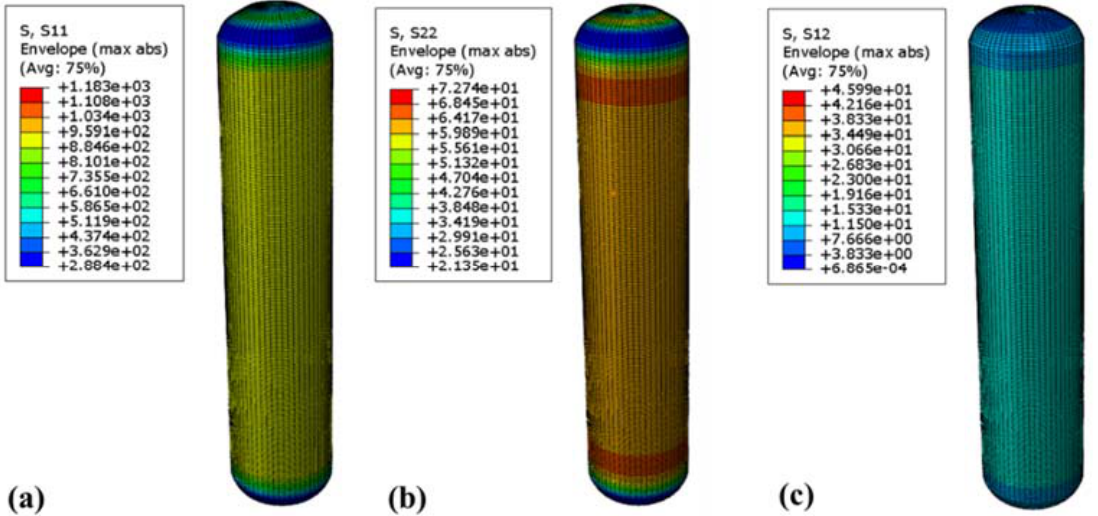
Figure 10. Cloud diagram of stress distribution of 70 MPa winding layer: ( a ) stress cloud diagram in fiber direction; ( b ) stress cloud diagram in perpendicular fiber direction; ( c ) stress cloud diagram in in-plane shear direction.